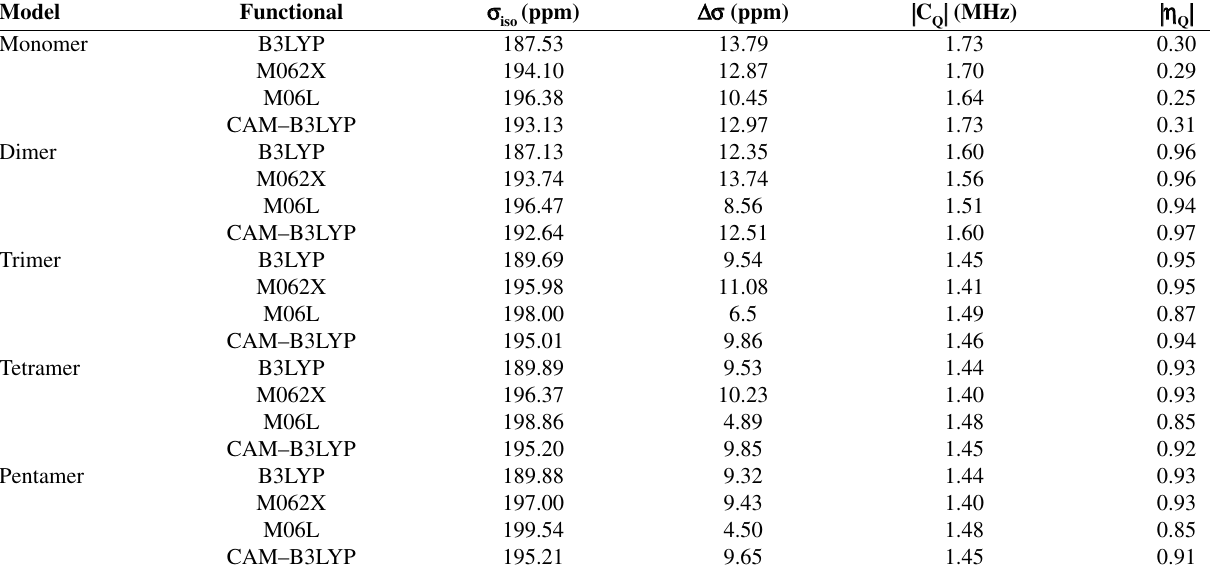
Table 2. Calculated nitrogen quadrupolar and chemical shift data for various Alanine hydrochloride clusters.